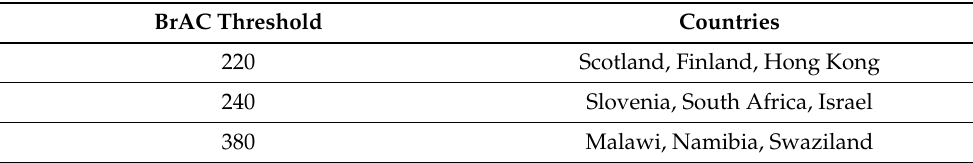
Table 1. BrAC thresholds for intoxication around the